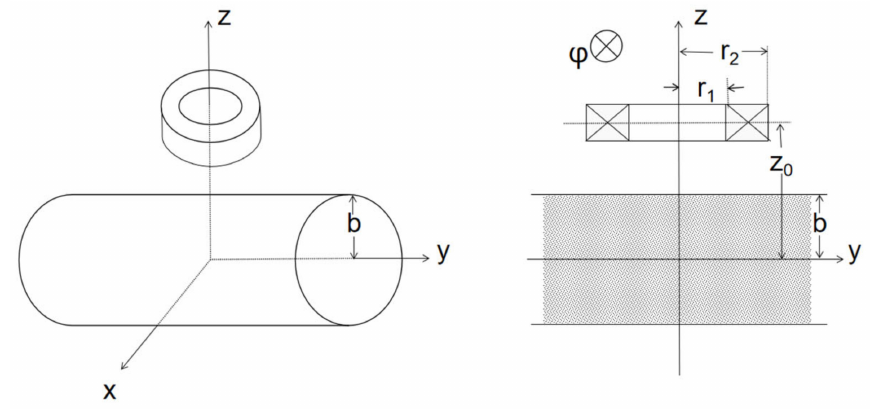
Figure 3. Full-view and cut-view of the cylindrical metal model.